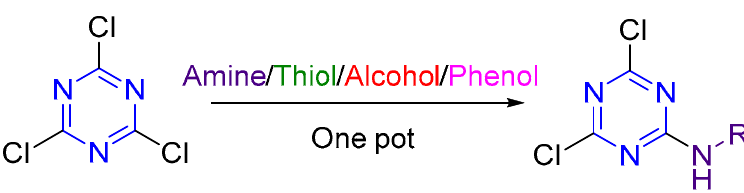
Figure 8. Competitive reaction of TCT with all nucleophiles in one pot.